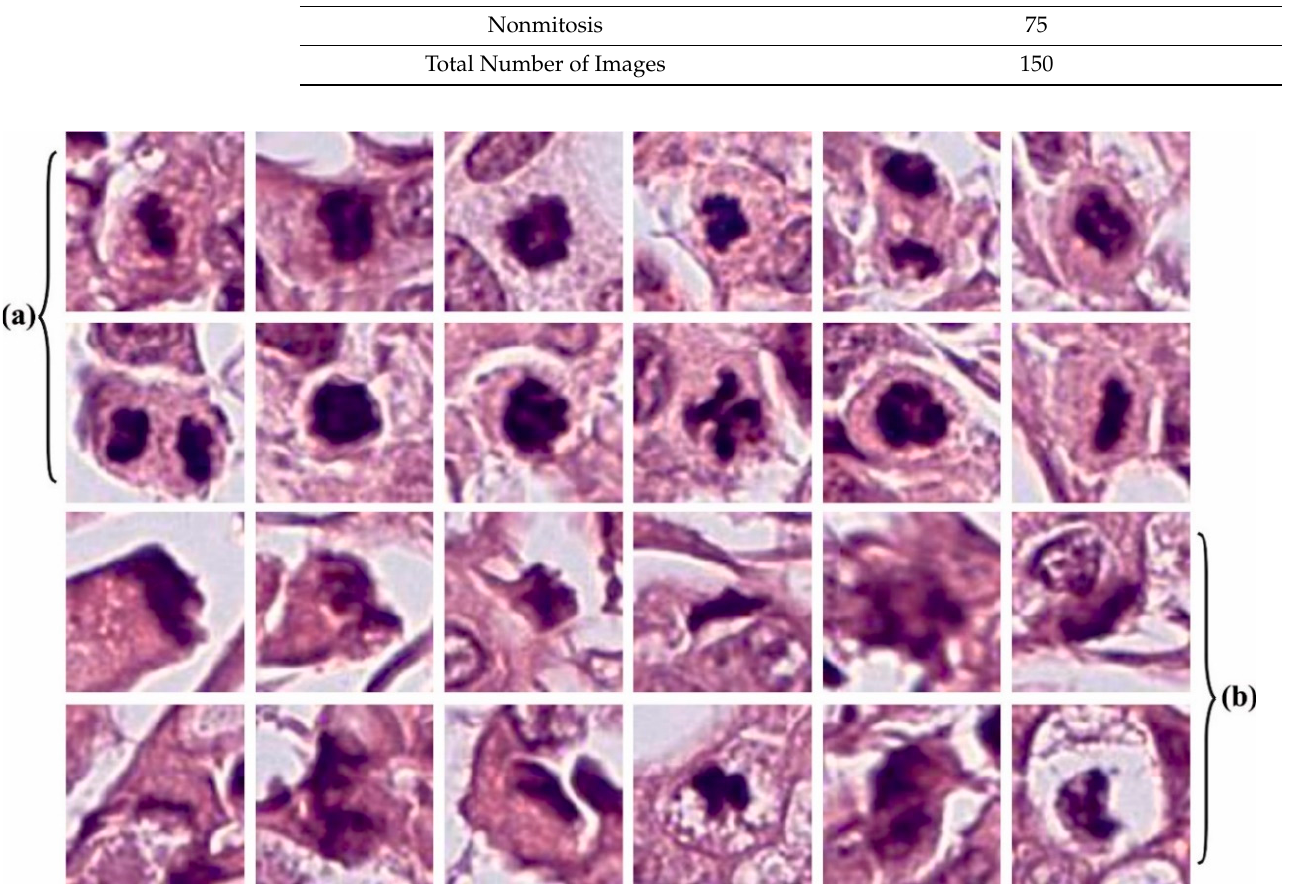
Figure 3. Confusion matrices of AHBATL-MNC system. ( a , b ) TR and TS databases of 60:40; ( c , d ) TR and TS databases of 70:30.